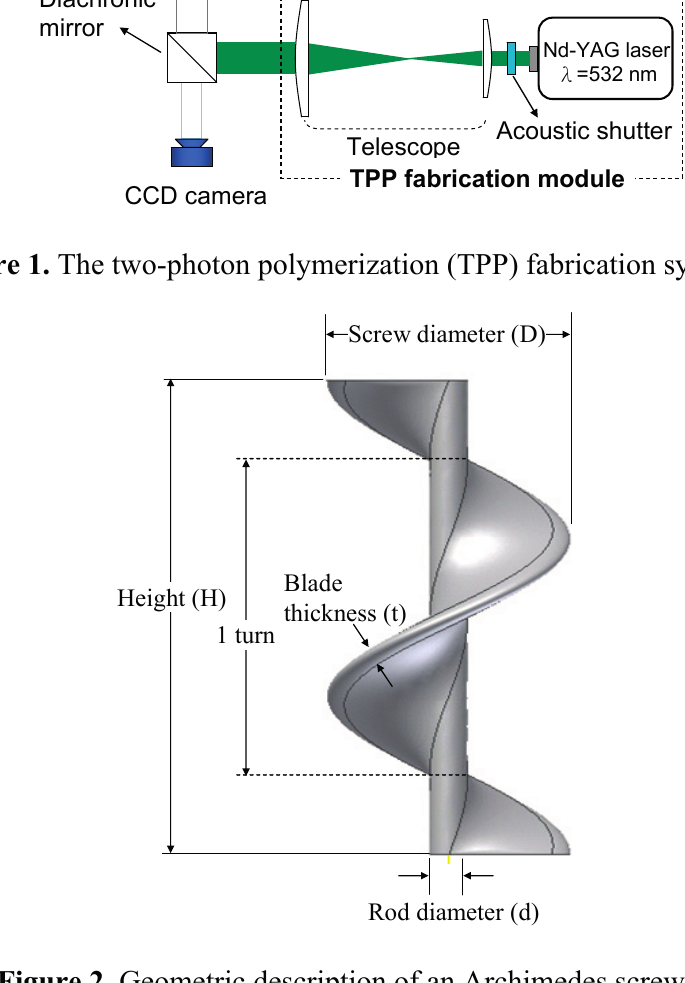
Figure 2. Geometric description of an Archimedes screw.